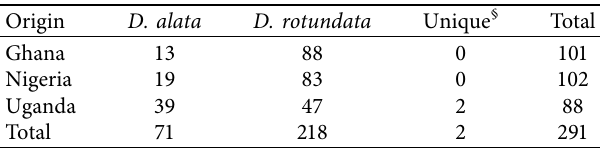
Figure 4: Phenotypic variability of plant morphology spines on stem. Table 3: Genotypes are classifed based on geographical origin and